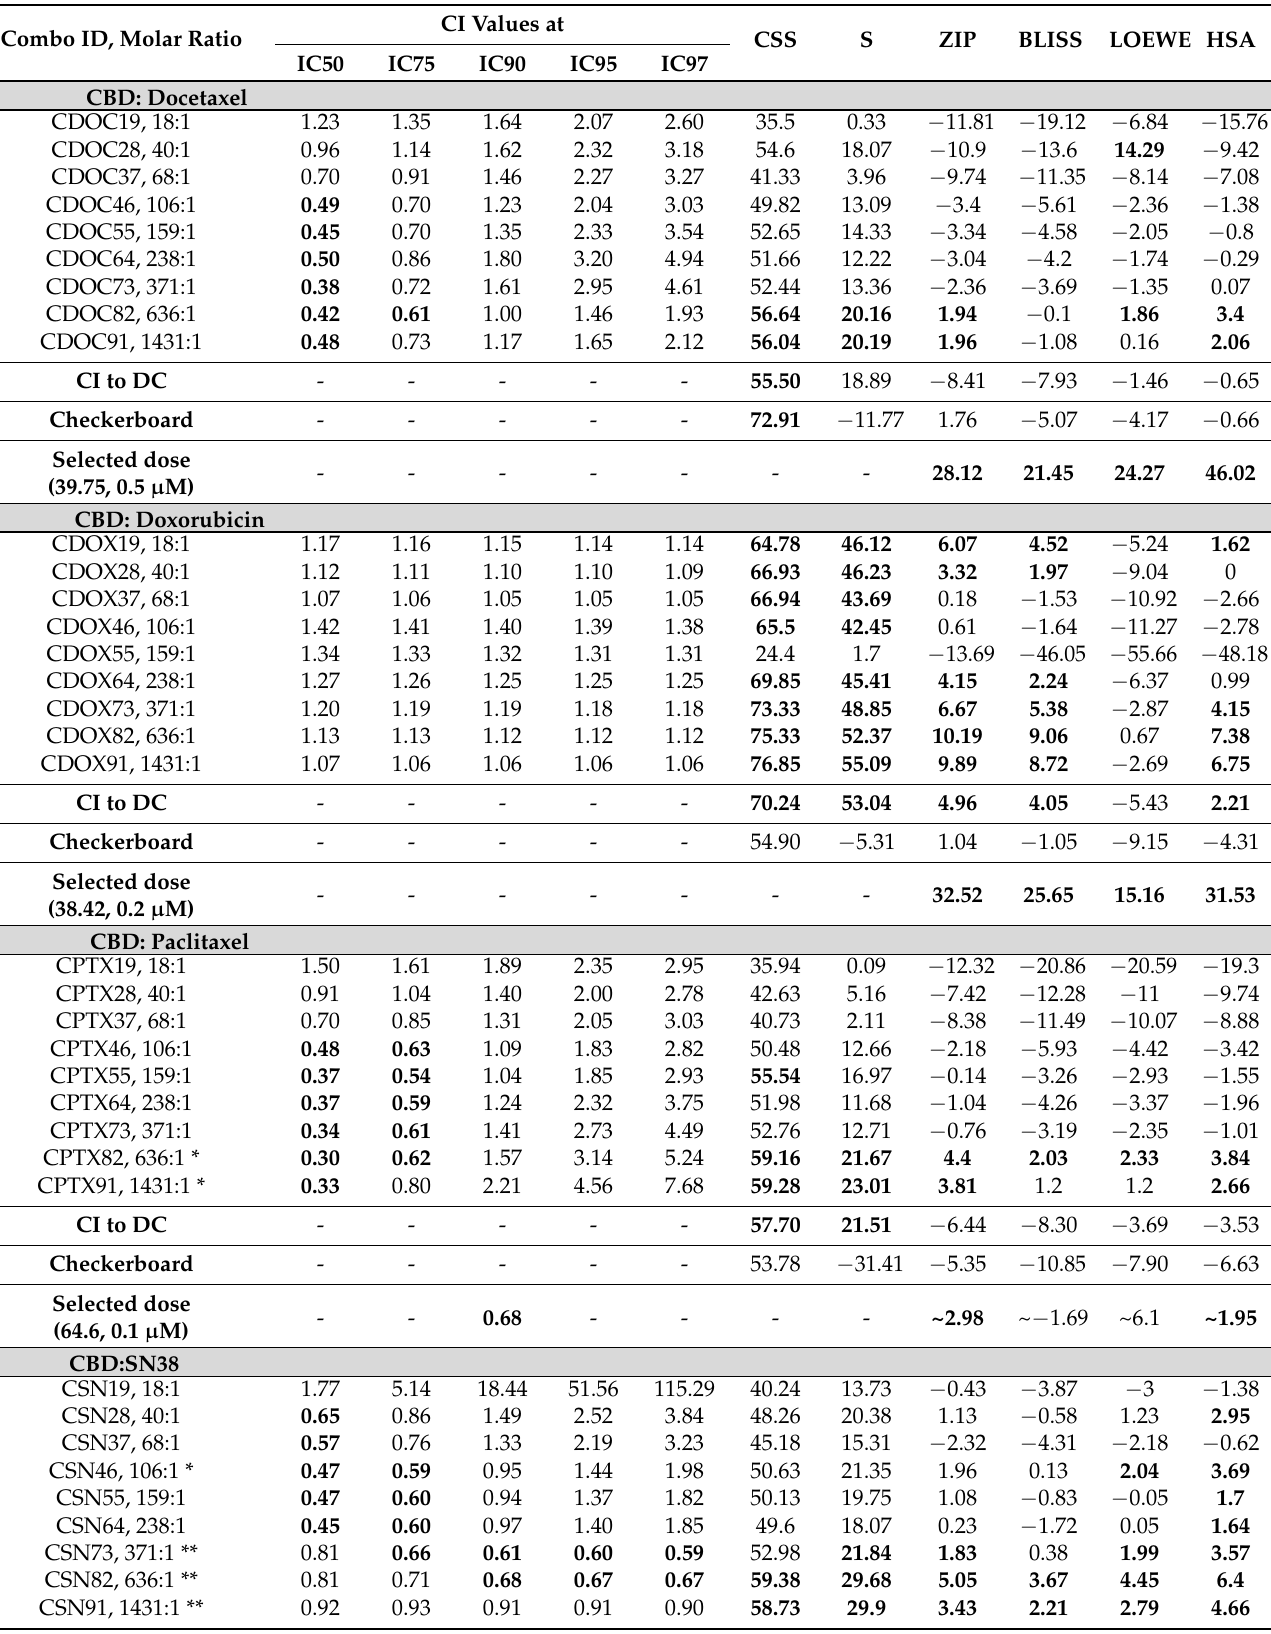
Table 1. Drug interaction analysis of cannabidiol (CBD) and the chemotherapeutic combinations in MCF7 breast cancer